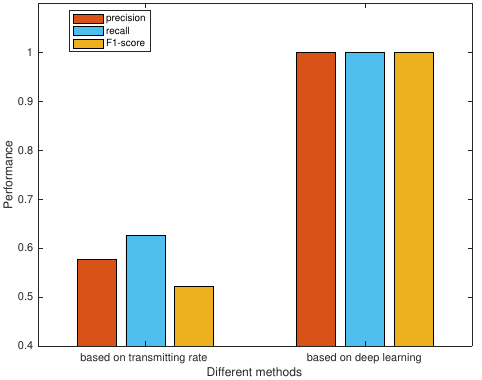
Figure 5. Performance of device identification